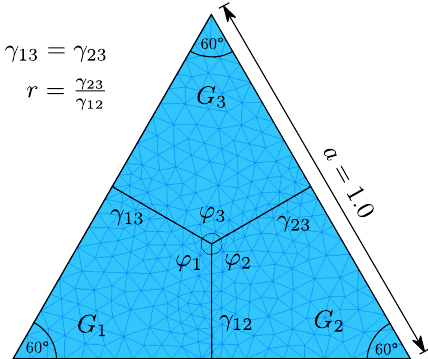
Figure 3. Initial state for the triple junction test: three grains are considered in an equilateral triangular domain. Dirichlet conditions (cid:126) v i = 0 ∀ N i ∈ ∂ Ω are considered in the domain border. The initial grain interfaces and the initial mesh are